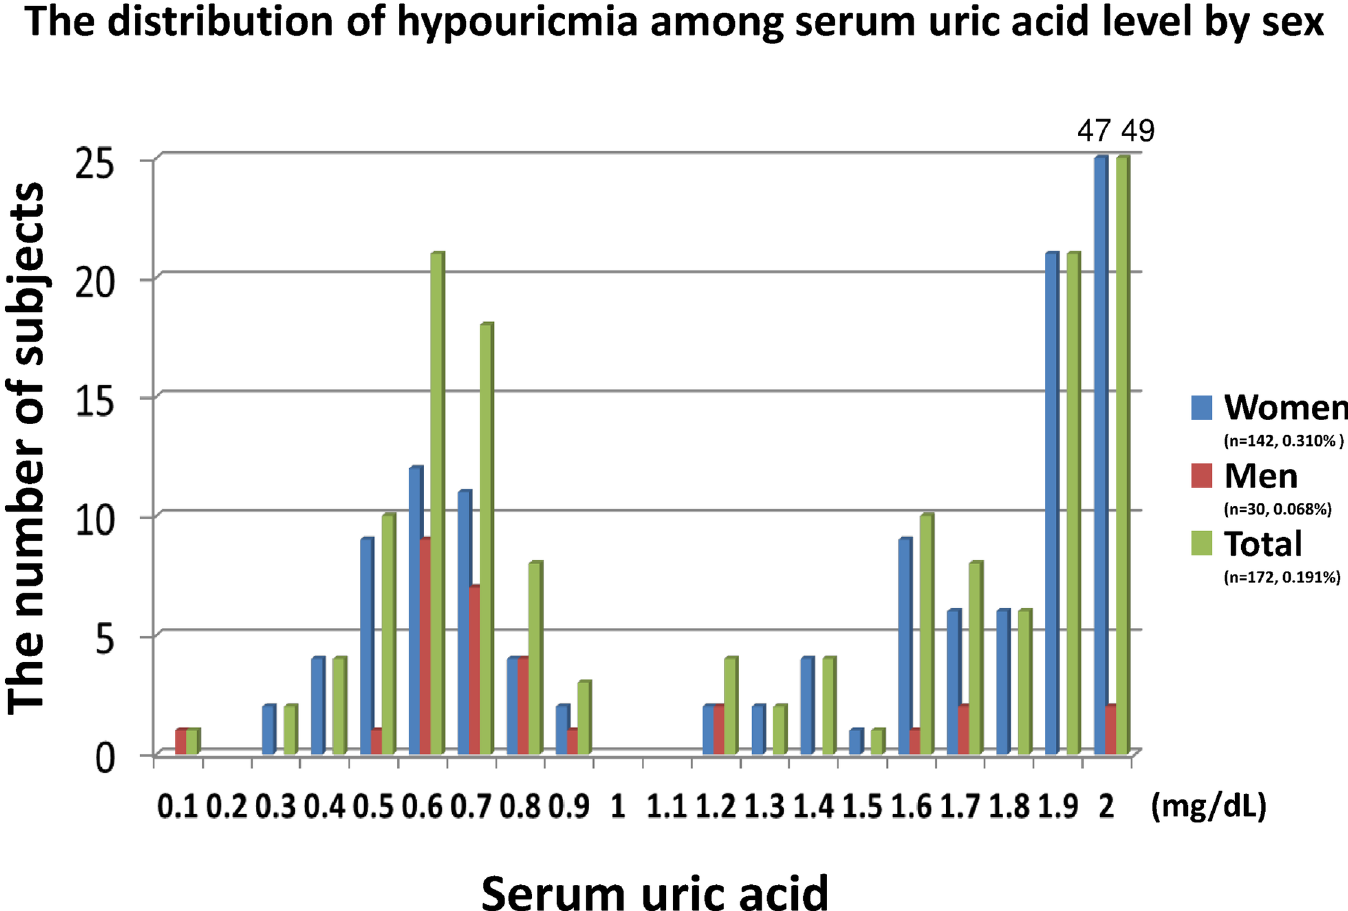
Fig 2. The distribution of hypouricemia among serum uric acid level by sex. The number of the women subjects whose serum uric acid of 2.0 mg/dL was 47. The numberof the total (men and women) subjects whose serum uric acid of 2.0 mg/dL was 49. These numbers were above this graph limit (25 subjects), and we showedthe numbers in the